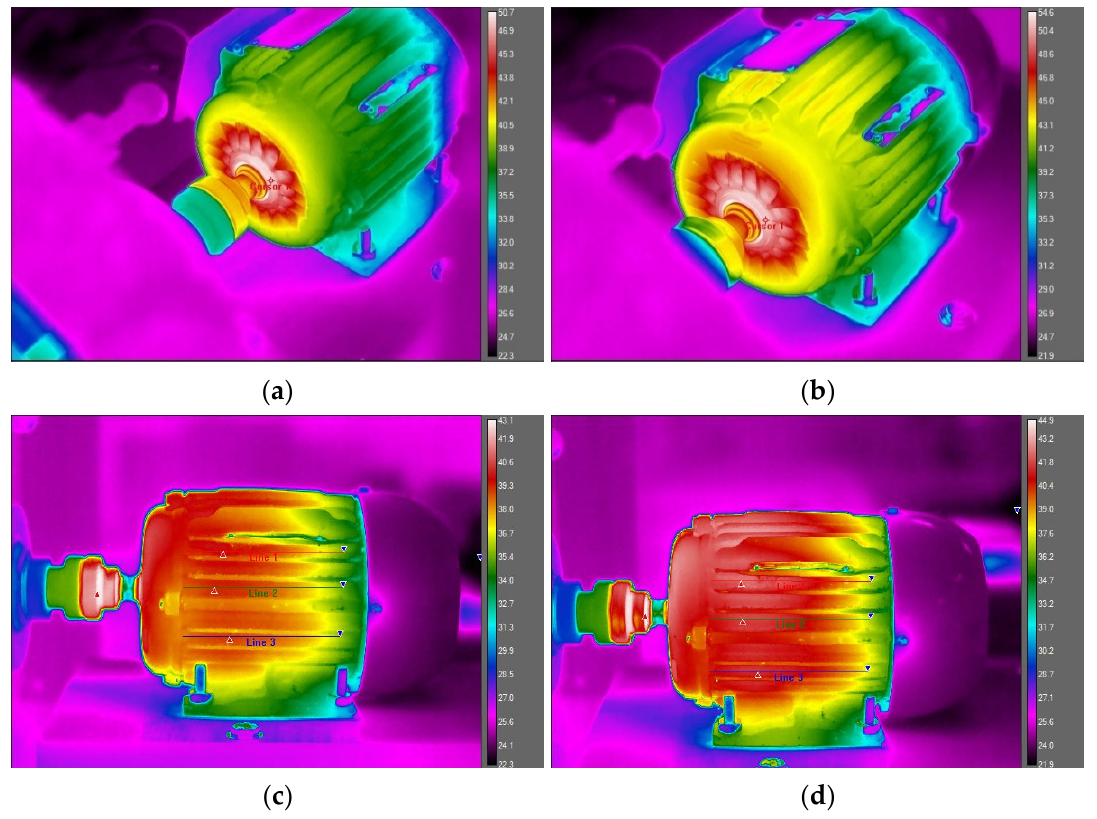
Figure 10. Thermographic images of the line-start permanent magnet motor in presence of 5th-order voltage harmonics in frontal and lateral view: ( a ) thermal equilibrium frontal view; ( b ) 25% of 5th-order voltage harmonic in frontal view; ( c ) thermal equilibrium lateral view; ( d ) 25% of 5th-order voltage harmonic in lateral view.